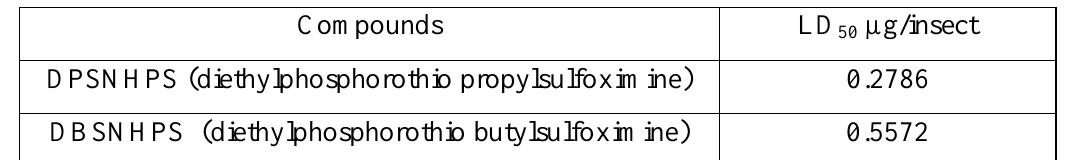
Table 1. Insecticidal activity Musca domestica.